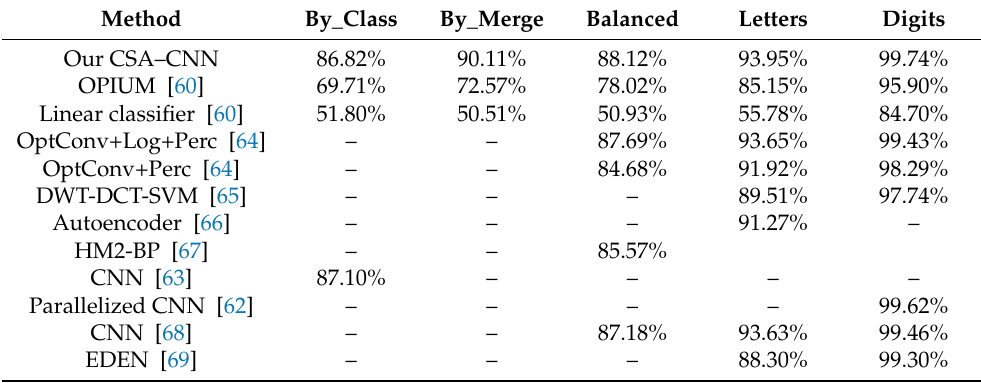
Table 5. Comparative accuracy of EMNIST classification